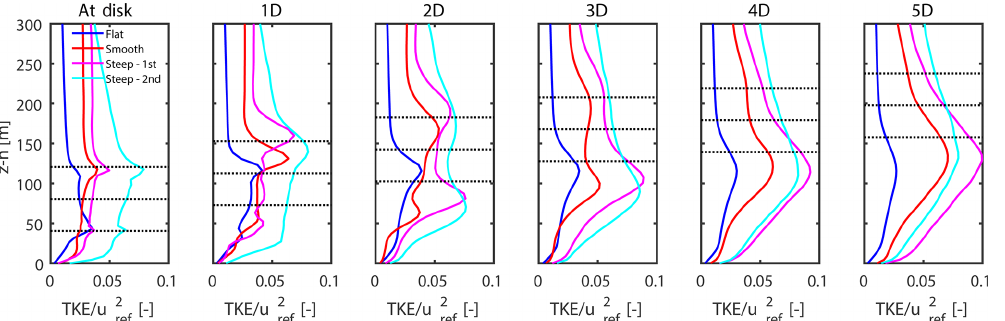
Figure 11. Vertical profiles of normalized turbulent kinetic energy for different cases.